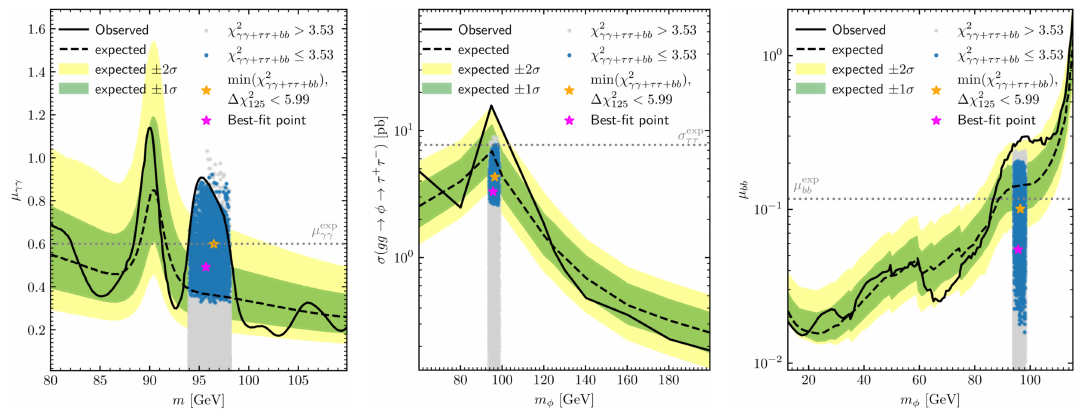
Figure 7 . Predicted signal rates µ γγ and µ bb (left and right plots) and cross sections σ ττ (middle plot) with regards to the three observed excesses. Blue points feature χ 2 the excesses at the level of 1 σ or better, whereas the grey points feature χ 2 magenta and orange stars are defined as in figure 3. Also shown are the experimentally observed and expected upper limits at the 95% confidence level. The green and yellow bands indicate the 68% and 95% intervals for the expected exclusion limit. The horizontal grey dotted lines indicate the central values of the observed signal strengths/cross section of the three